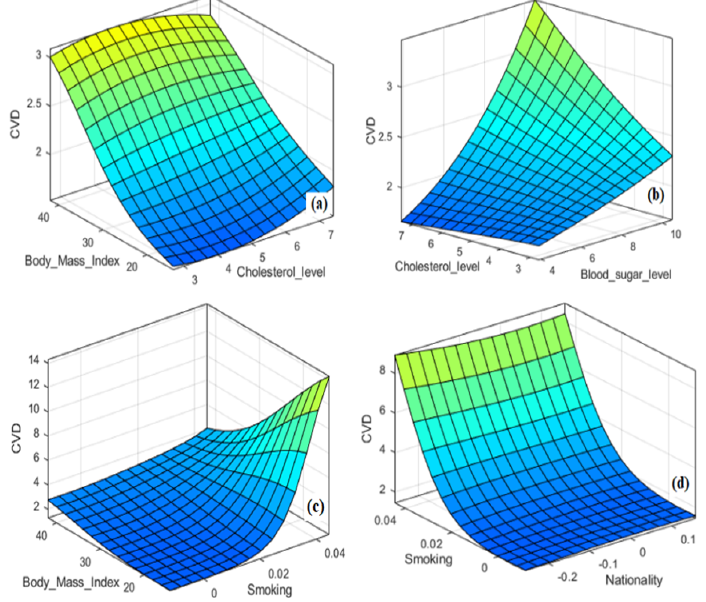
Figure 9. Three-dimensional relations of CVD with BMI, glucose level, smoking and nationality; see abbreviations in